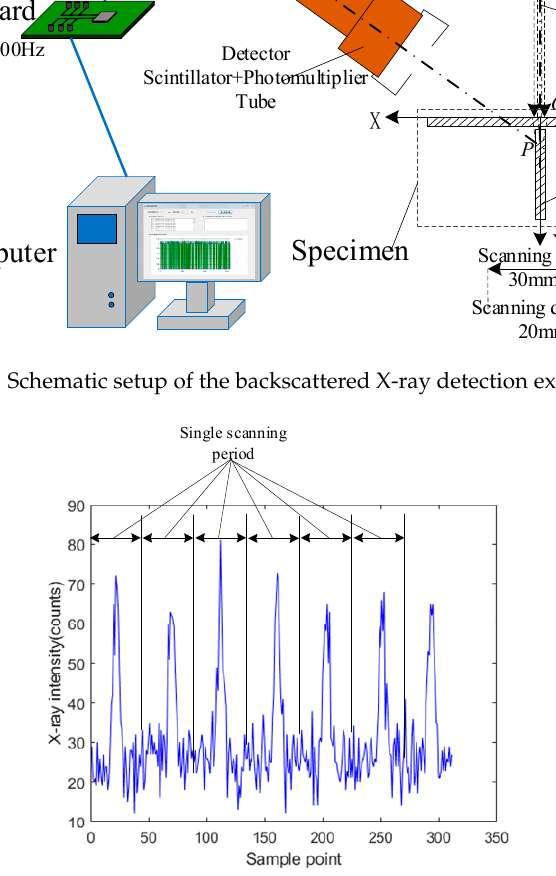
Figure 15. The original signals at 50 Hz sampling frequency.